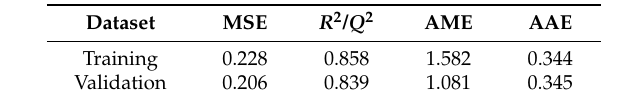
Figure 1. Distribution of logarithmic skin permeability predicted by quantitative structure-activity relationship developed in this study (predicted log Kp ) against values experimentally observed (observed log Kp ) for ( a ) 85 compounds in the model training dataset, and for ( b ) 21 compounds in the model validation dataset. Diagonal solid lines in the graphs represent where the predicted log Kp would equal the observed log Kp for a target compound. Table 4. Fitting ability and predictive capability of quantitative structure-activity relationship for estimating skin permeability a